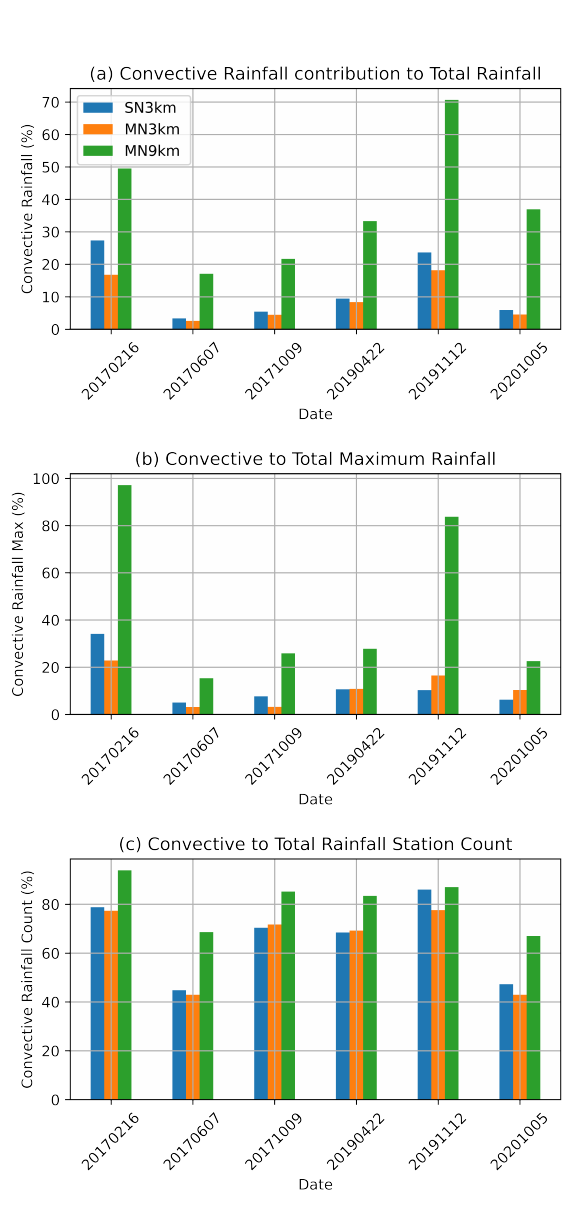
Figure 14. Percent contribution of convective rainfall to ( a ) total rainfall, ( b ) maximum rainfall and ( c ) number of stations reporting rainfall of more 0.1 mm of rain.